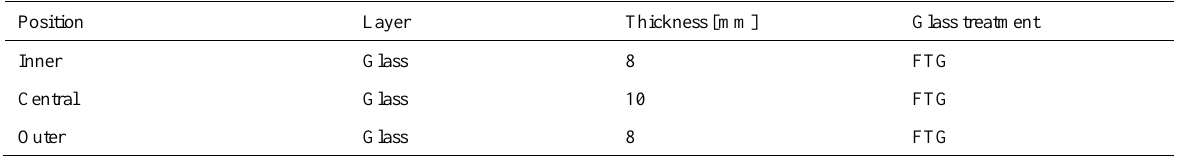
Table 4: Composition of the central laminated glass